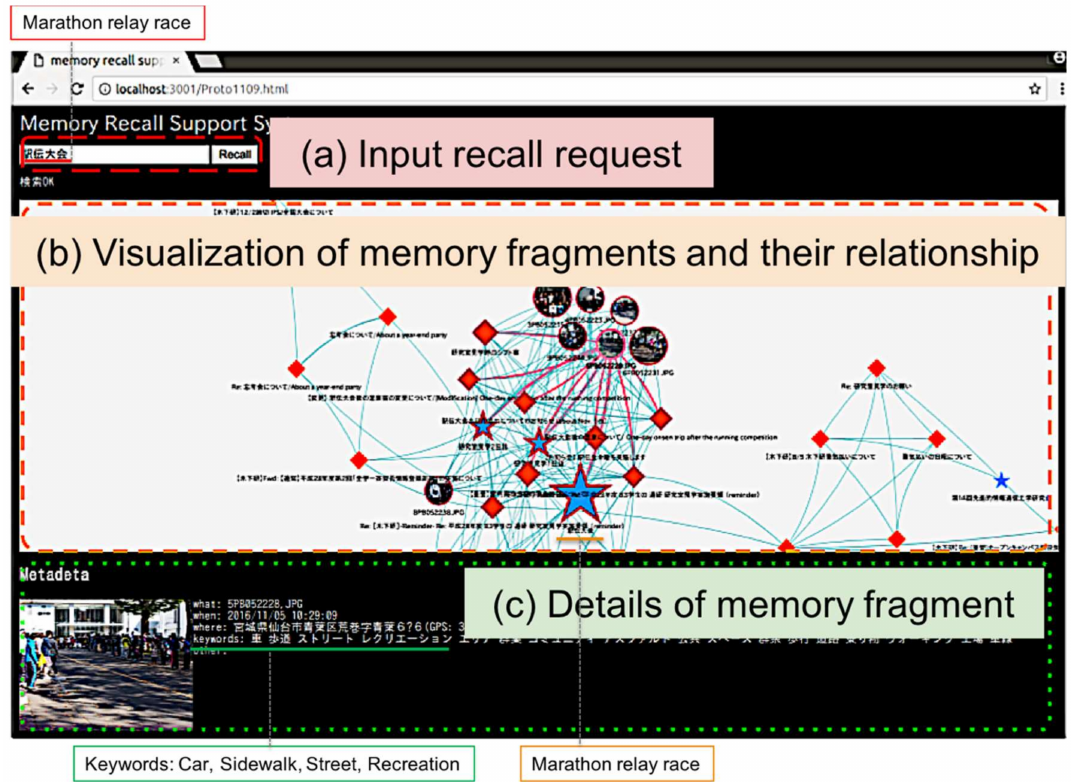
Figure 9. Information presentation